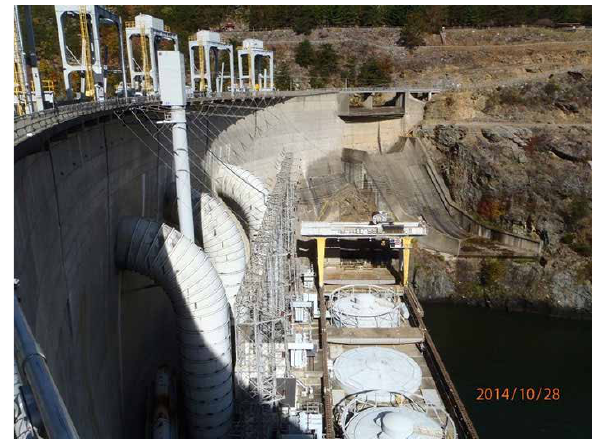
Figure 8. Experimental robot crawler used for NDE of Claytor dam